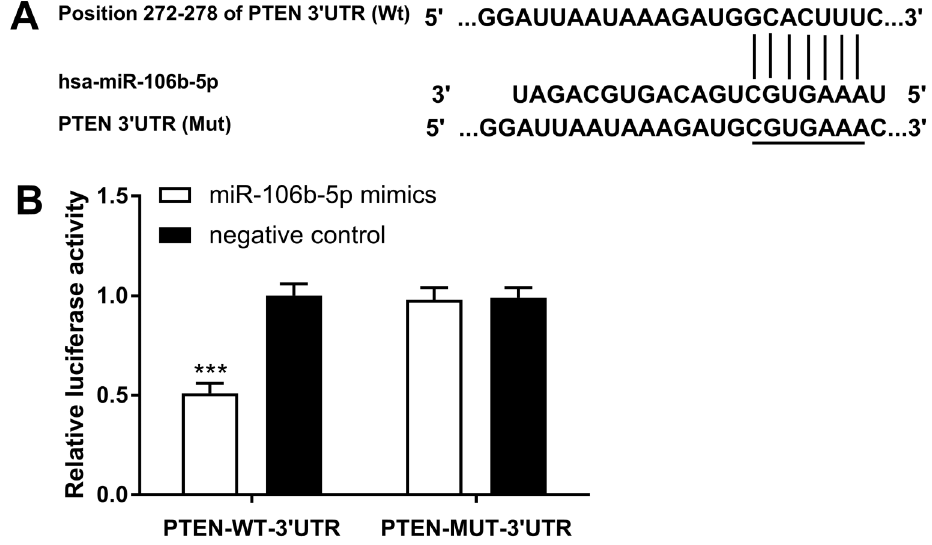
Figure 2. Relationship between PTEN and miR-106b. A , PTEN and miR-106b binding target sites predicted by Target Scan. B , Luciferase activity transfected with indicated luciferase reporters was determined using luciferase report assay. Data are reported as means ± SD. ***P o 0.001 vs miR-106b mimics and PTEN-MUT-3 0 UTR co-transfection ( t -test).